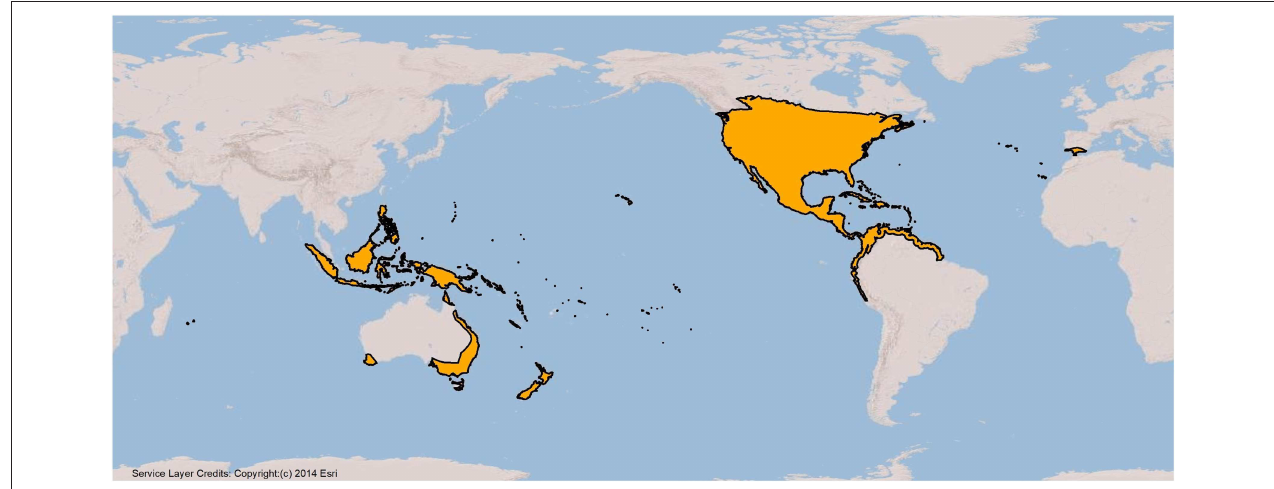
FIGURE 1 | Map showing global range of monarchs (orange shows known